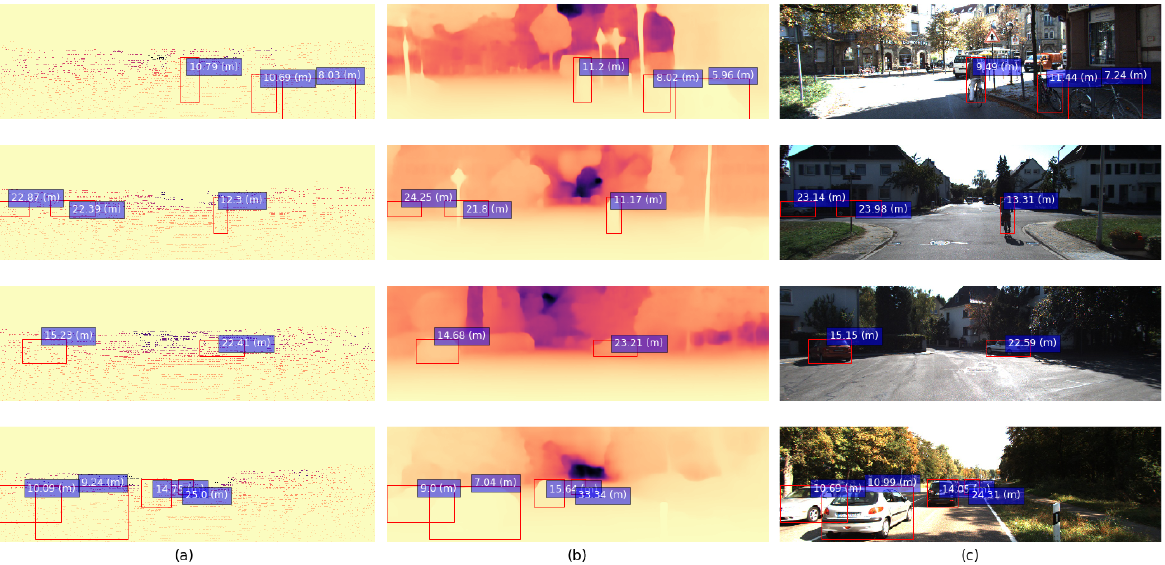
Figure 5. Examples demonstrating the proposed model’s performance on several samples from the validation and testing sets: ( a ) ground-truth LIDAR point clouds; ( b ) corresponding Monodepth2- generated depth maps; ( c ) distances predicted by the CDR